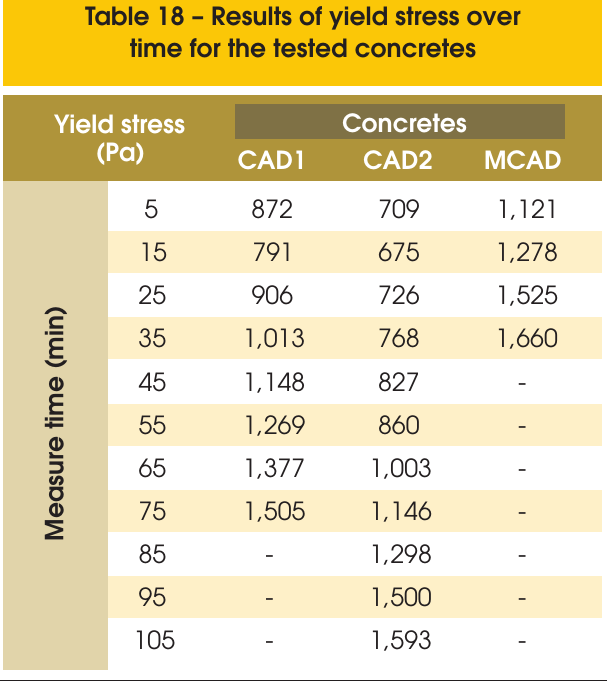
Table 18 – Results of yield stress over time for the tested